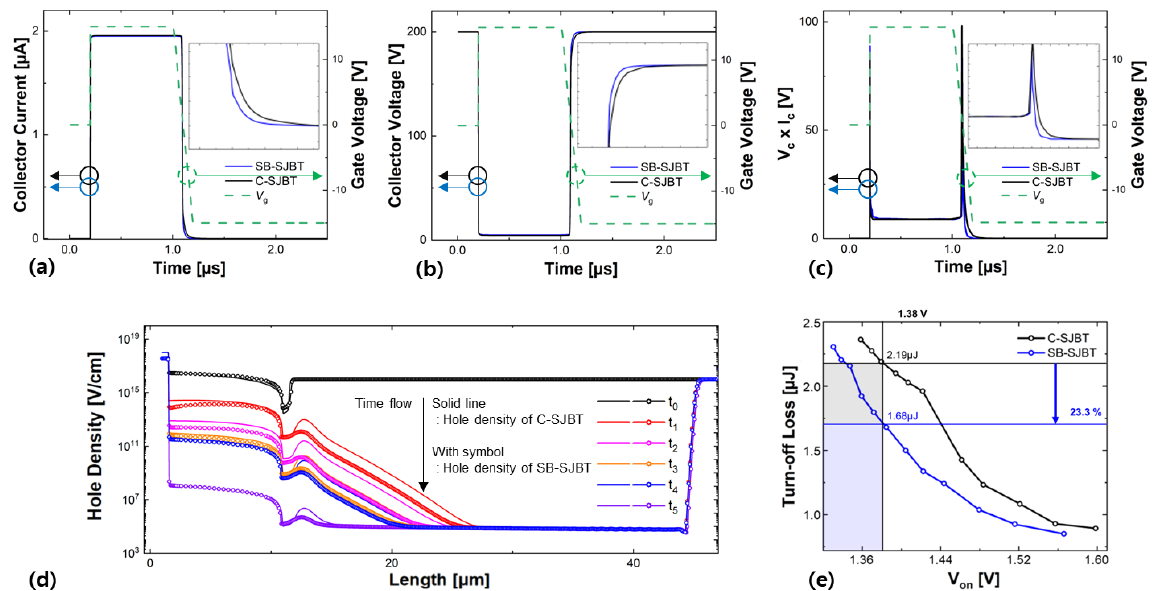
Figure 3. ( a ) The method for calculating the turn-off loss: the turn-off waveform of the collector current; ( b ) the collector voltage; and ( c ) power dissipation. ( d ) The graph shows the process of hole extraction over time after the C-SJBT and SB-SJBT are turned off. ( e ) The trade-off was improved by about 23.3% based on a V on of 1.38 V.